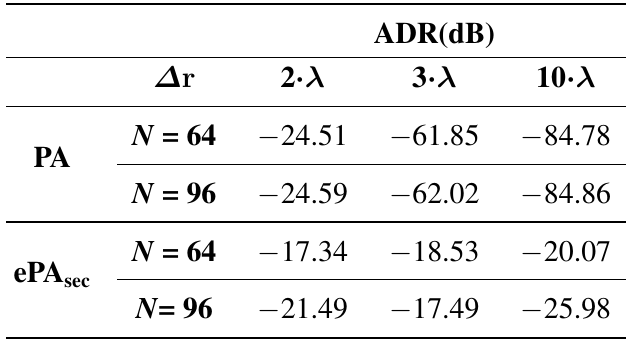
Table 3. Axial dynamic range (ADR) values obtained with PA and ePA N = 64 and N = 96 elements and different axial distances between reflectors ( ∆r ).